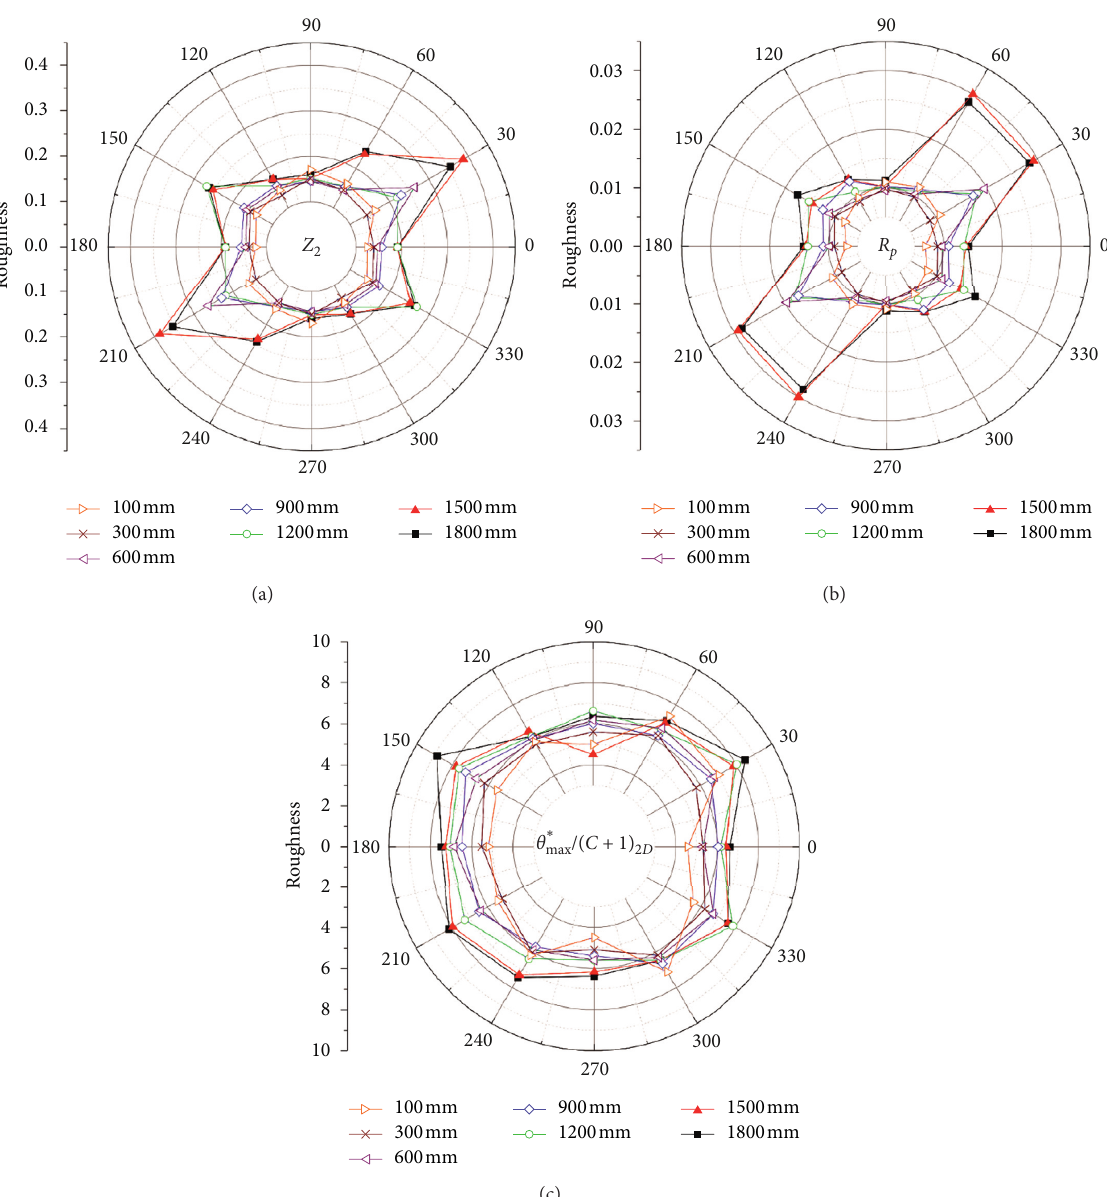
∗ / ( C + 1 ) on the rock joint surface 2 , R p , and θ 2 D max